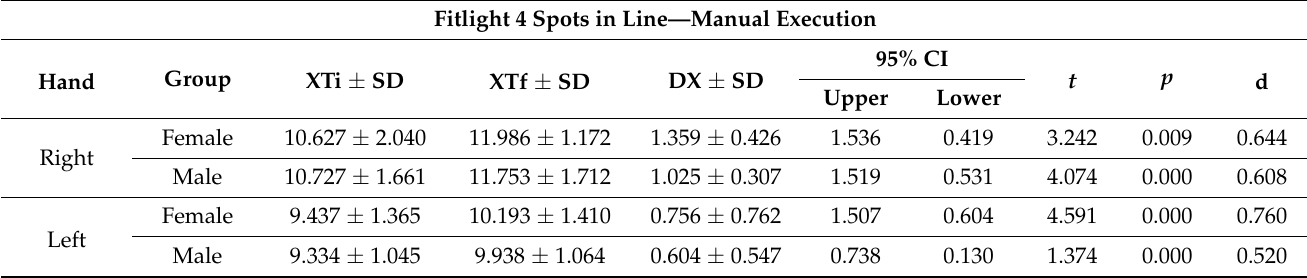
Table 1. Descriptive statistics of Fitlight test 4 spotlights in line—manual